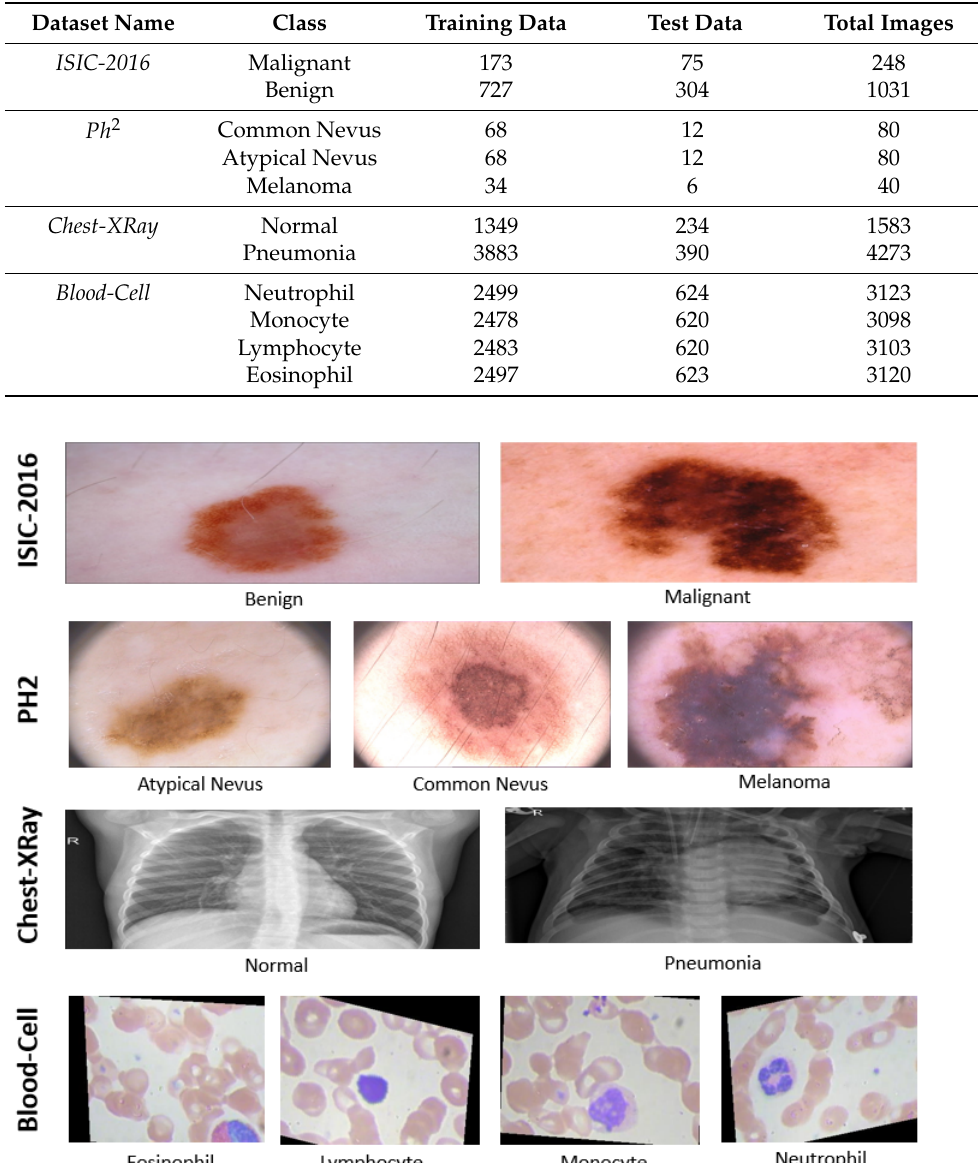
Table 2. Description of the datasets.